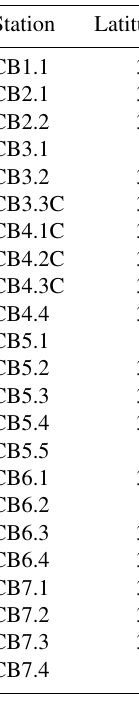
Table A1. Characteristics of observation stations.